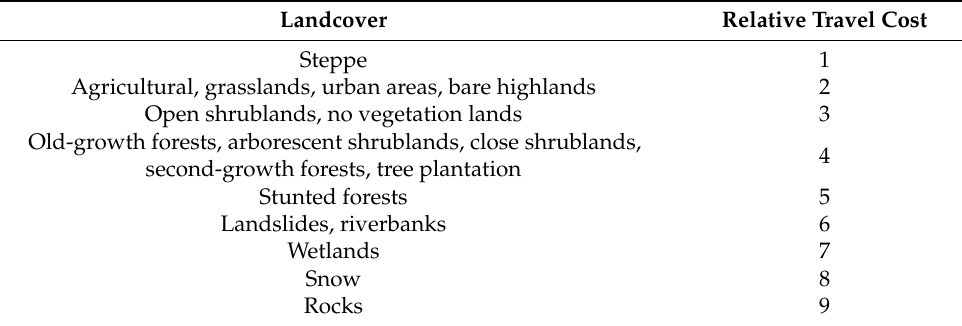
Table 2. Relative travel cost for each land cover class. Landcover Relative Travel Cost Steppe